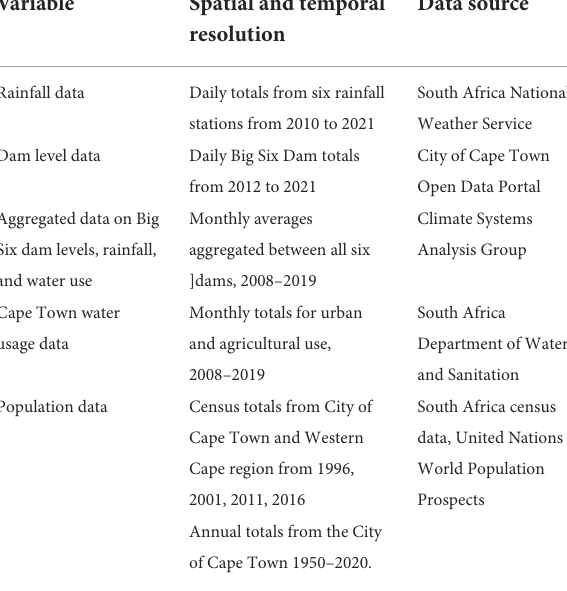
TABLE 1 Data sources (URLs provided in Appendix A).